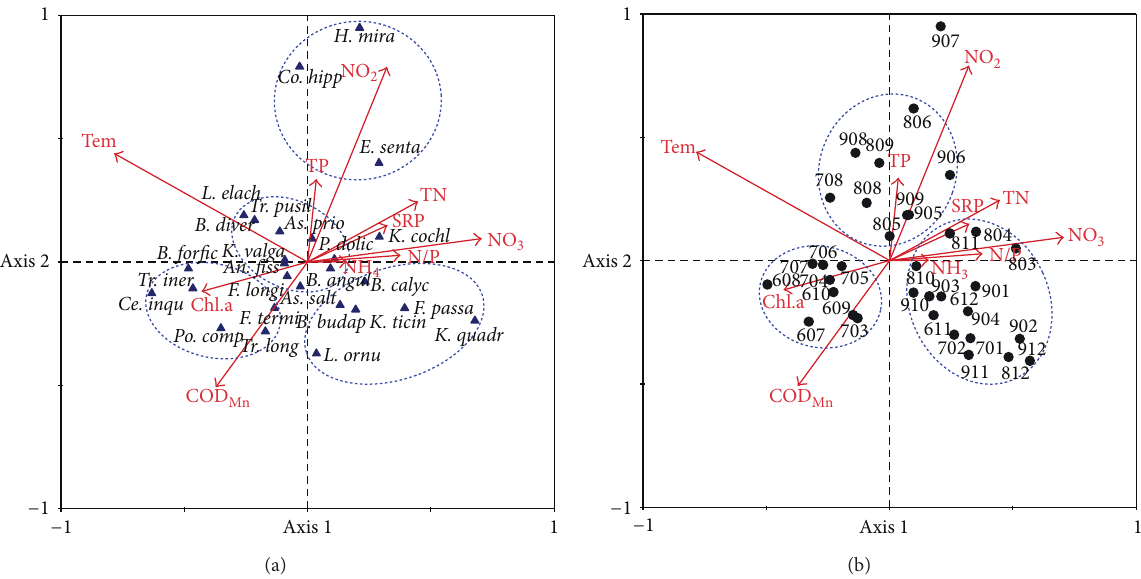
Figure 5: CCA ordination plots. Species abbreviations are presented in Table 1. (a) Species and environmental variables. (b) Samples and environmental variables. Numbers represented sample times, for example, 907 means Jul 2009. The eigenvalues for the first two axes are 0.18 and 0.126. The Monte Carlo permutation test was significant on the first axis ( 𝐹 = 3.965 , 𝑃 = 0.002 ) and on all axes ( 𝐹 = 1.885 , 𝑃 = 0.002